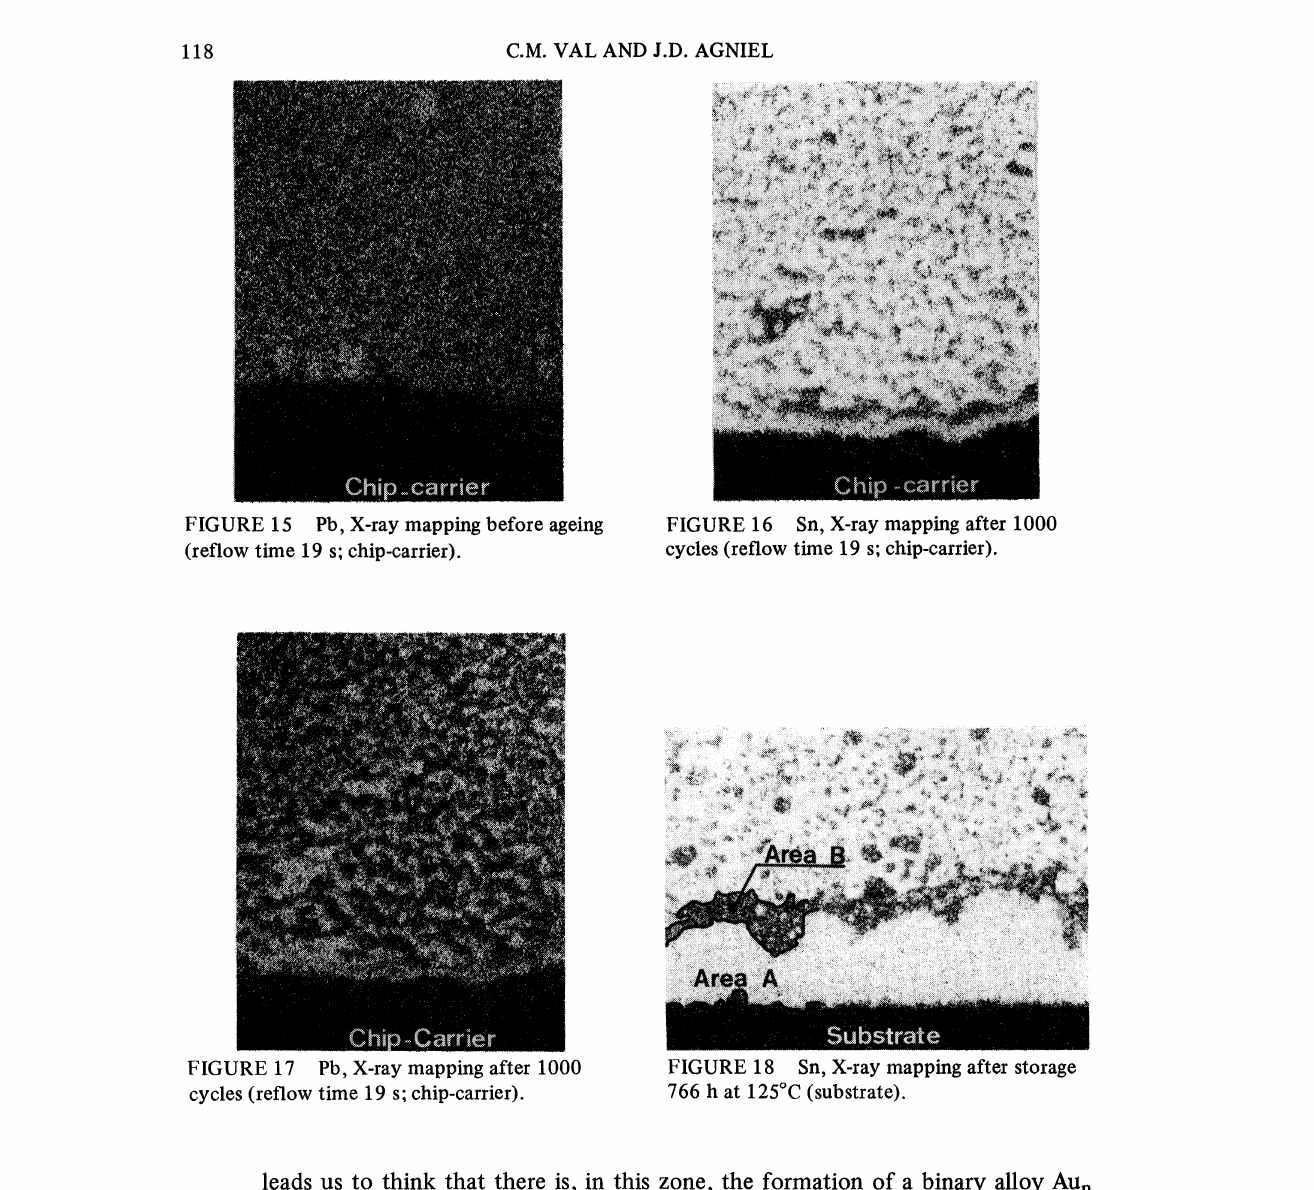
FIGURE 17 Pb, X-ray mapping after 1000 cycles (reflow time 19 s; chip-carrier).